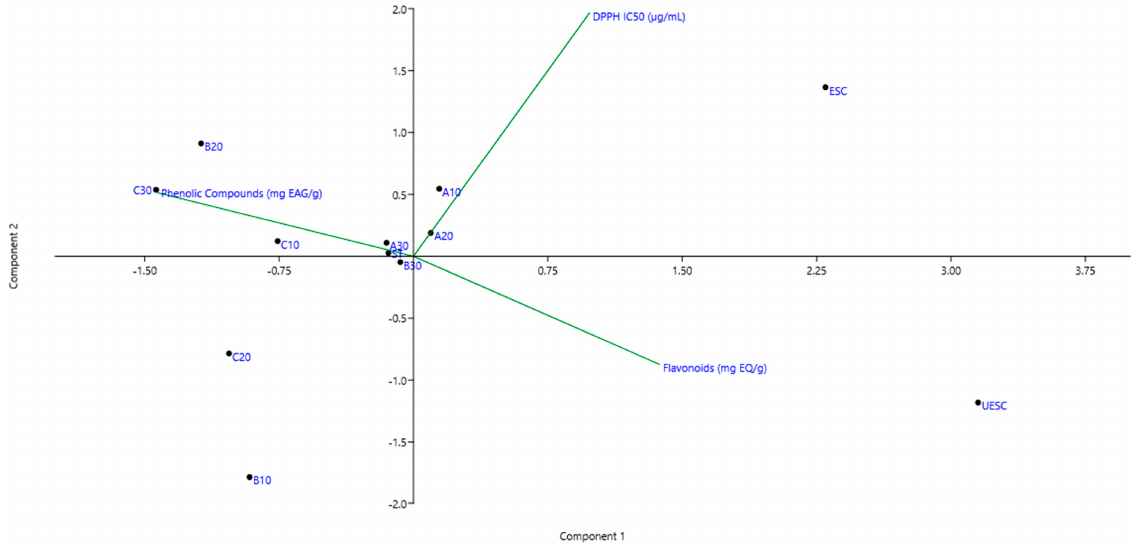
Figure 2. Principal component analysis of the samples obtained by the different extraction methods (PC scores) according to the number of loadings (content of phenolic compounds, flavonoids, and DPPH radical scavenging ability).